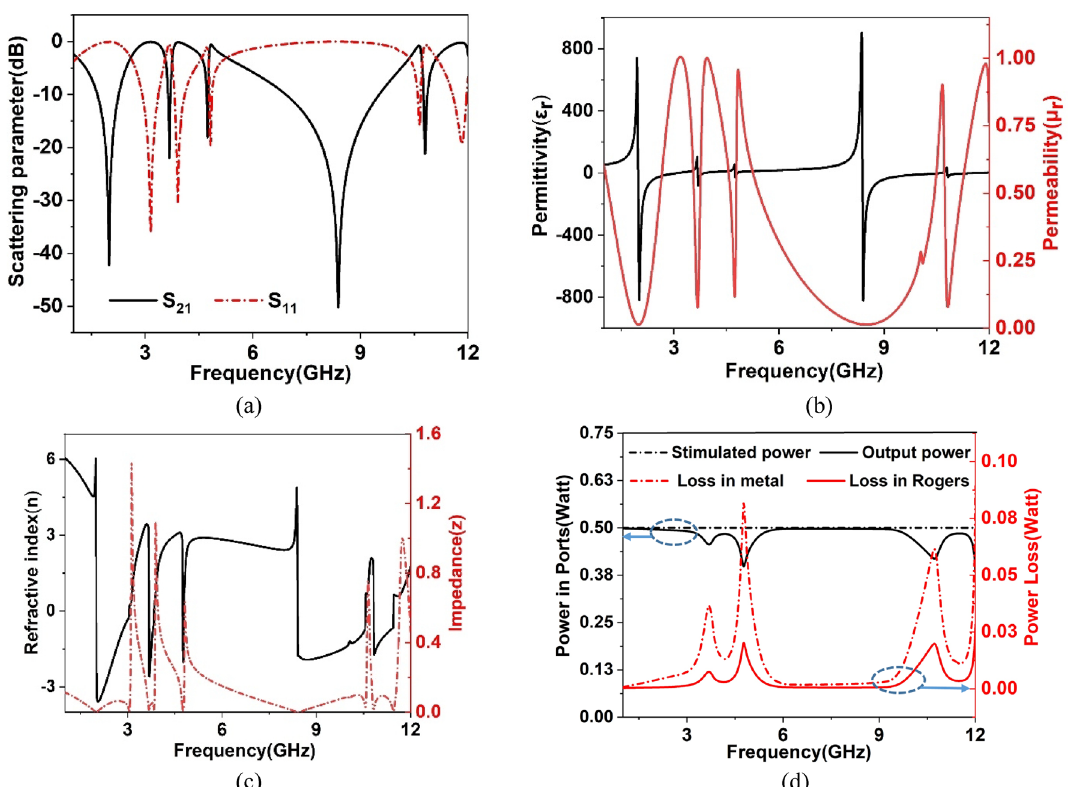
Figure 9. ( a ) scattering parameters(S 21 and S 11 ), ( b ) permittivity and permeability, ( c ) refractive index and impedance ( d )